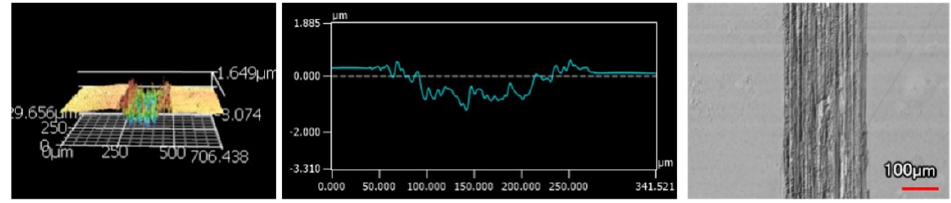
Figure 16. 45 μ m Thick Ni-P Coating 100 Passes of the Spherical Indenter.